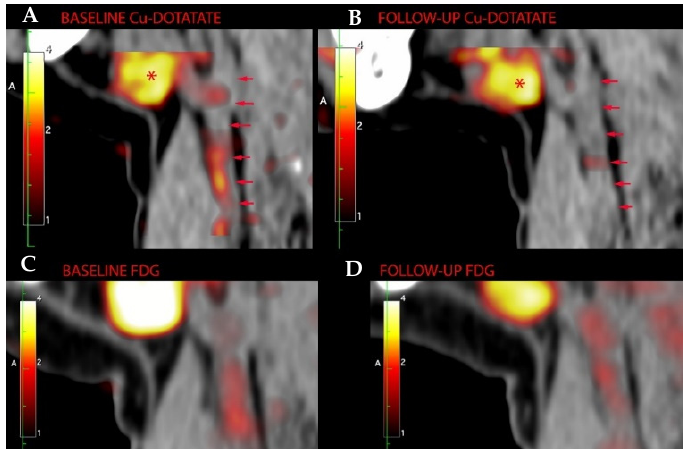
Figure 2. Sagittal [ 64 Cu]DOTATATE-PET/CT images from a participant treated with liraglutide. The left carotid artery is outlined at ( A ) baseline (SUV mean = 1.2) and ( B ) follow-up examination (SUV mean = 0.92). * Physiological uptake in submandibular gland. The lower panels show [ 18 F]FDG uptake from the same participant for comparison at ( C ) baseline and ( D ) follow-up.